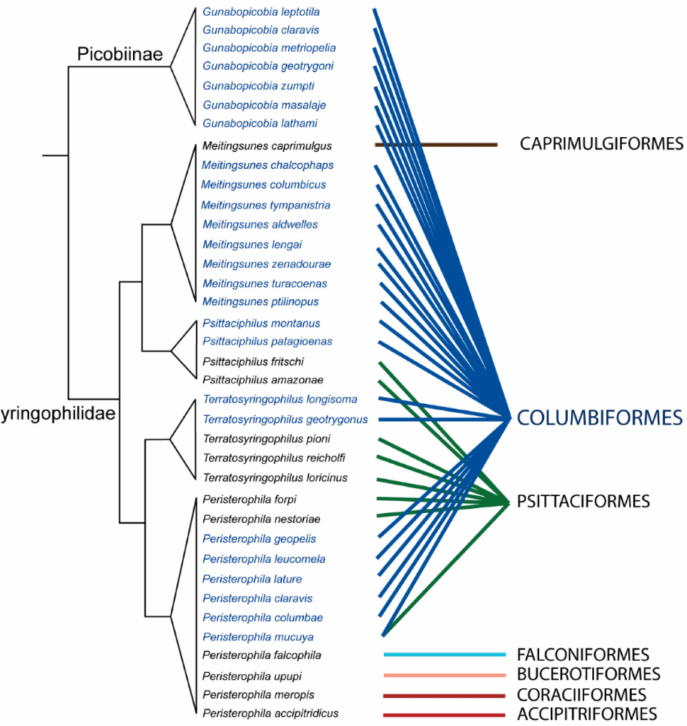
Figure 4. Phylogenetic tree of selected genera of Syringophilidae associated with differential hosts order. The analysis shows that except the genus Gunabopicobia which represents subfamily Picobiinae, other syringophilinae genera form two distinct clades: Peristerophila + Terratosy- ringophilus (supported by synapomorphies: the presence of large finger-like protuberances on the hypostomal apex, presence of parallel apodemes I, and presence of dimorphic females) and Meitingsunes + Psittaciphilus (supported by synapomorphy: the presence of the constricted posterior end of the